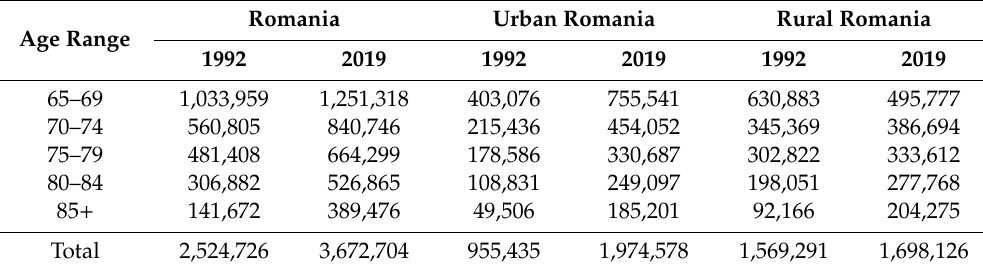
Table 3. The older population of Romania per age cohort [26].